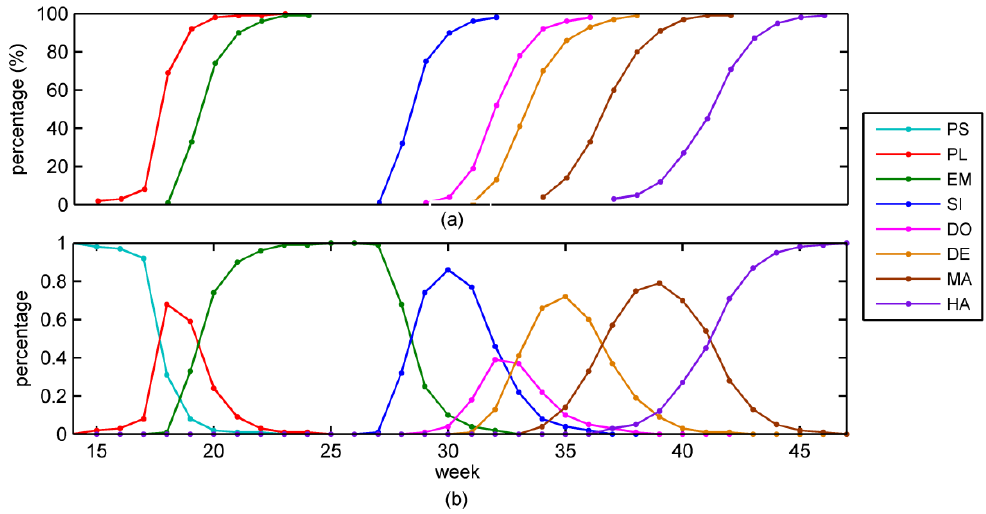
Figure 4. NASS’s CPRs Normalization, Iowa (2011). PS = pre-season. PL = planted, EM = emerged, SI = silking, DO = dough, DE = dent, MA = mature, and HA = harvested. ( a ) original corn progress percentages; ( b ) normalized corn progress